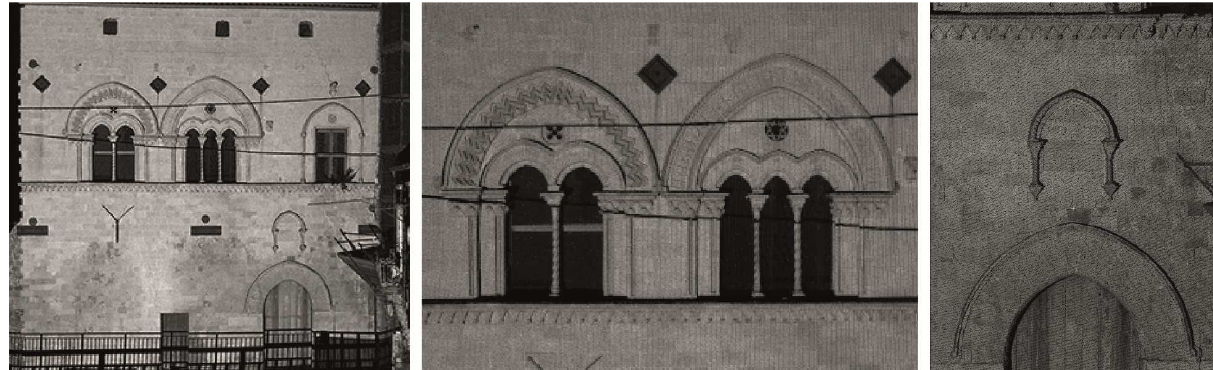
Figure 2. Complexity captured by all the point clouds referred to an architectural context of